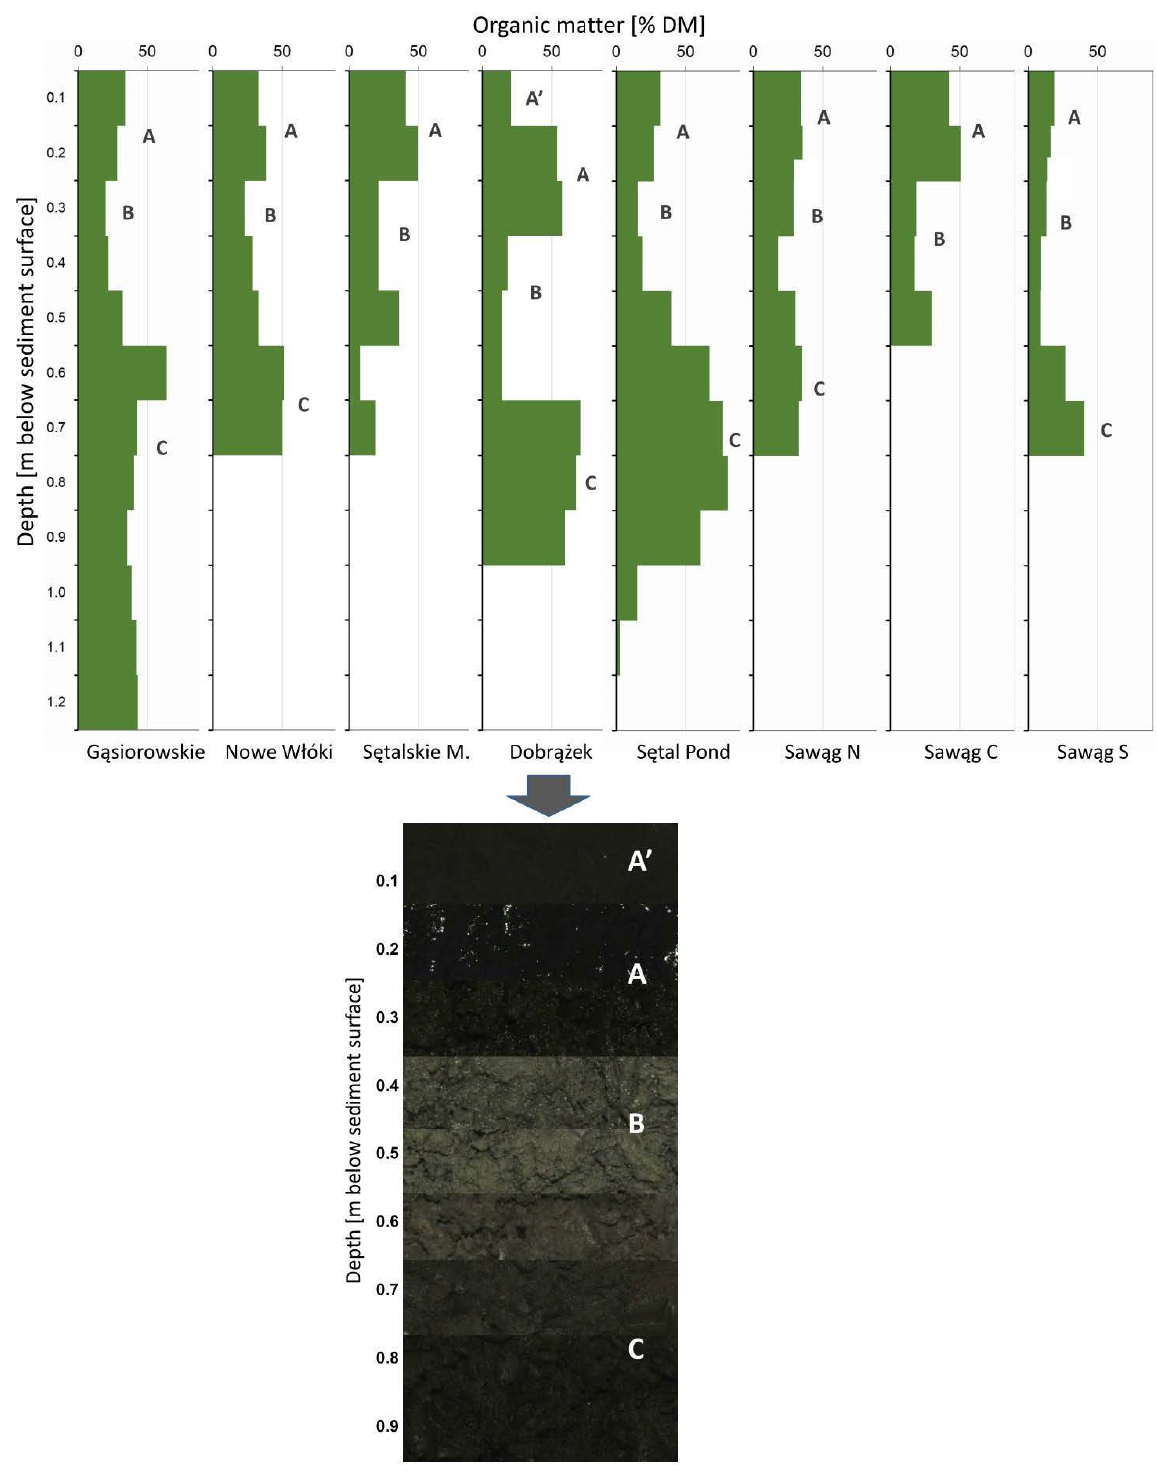
Figure 2. Organic matter distribution in the whole sampled sediment cores in the analysed water bodies, and a visual example of the layers in the core taken from lake Dobr ąż ek; A’—unconsolidated surface sediments; in Lake Dobr ąż ek these were atypical, disturbed by the increased influx of matter from the catchment area (reconstruction of the main route near the lake); A—sediments from after the lake reclamation, with more stabilised lower parts; B—more mineralised sediments (meadow soil) before reclamation, likely influence of the drying period; C—deeper layers with more organic matter from before the lake was